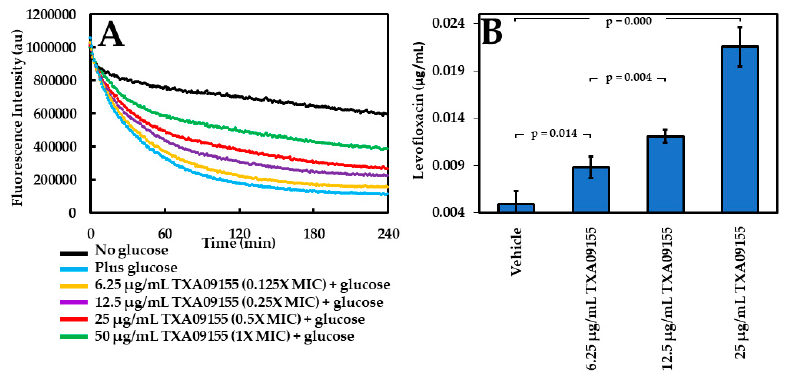
Figure 3. ( A ) TXA09155 concentration-dependent inhibition of EtBr efflux. ( B ) Levofloxacin accumulation in the presence of TXA09155. Experiments were repeated at least three times; a representative experiment is shown in ( A ), and values in ( B ) represent mean ± S.D.